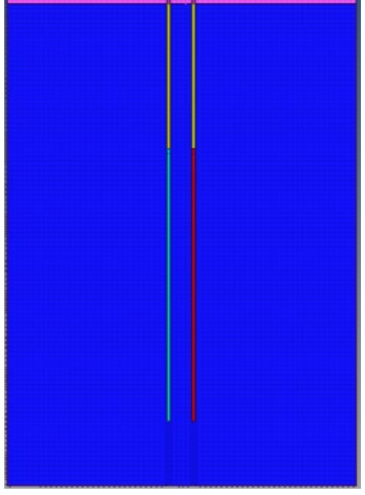
Figure 12. Diagram of grid